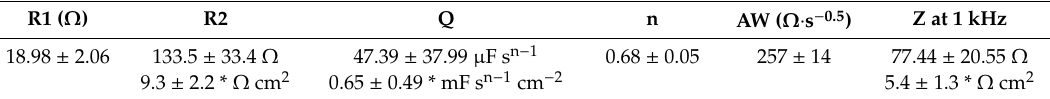
Table 1. Summary of fitted parameter results for impedance spectroscopy measurements ( N = 10) a